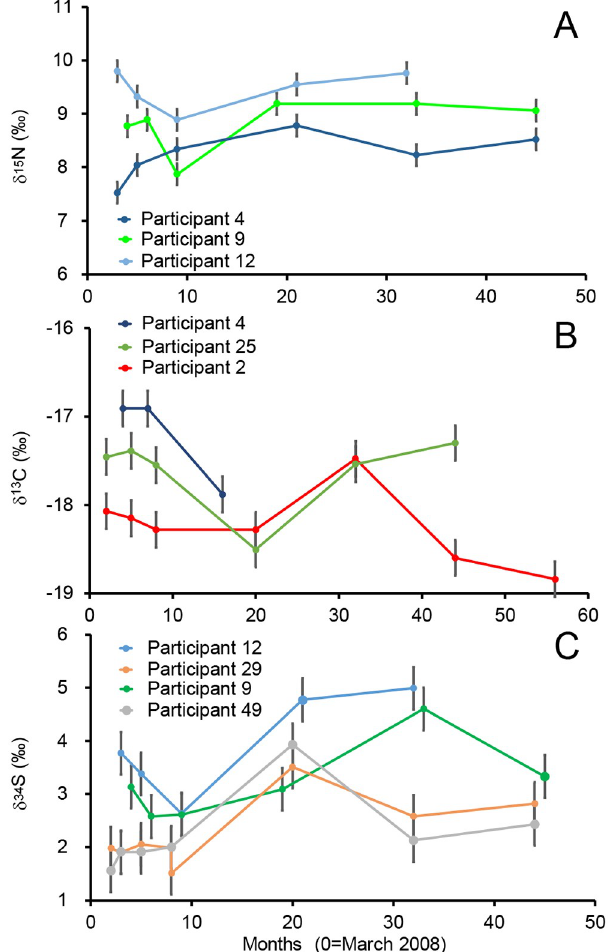
Fig 5. Isotopic profiles for participants with the most variable isotopic values (Table 7) for A. δ 15 N hair values; B. δ 13 C hair values and C. δ 34 S hair